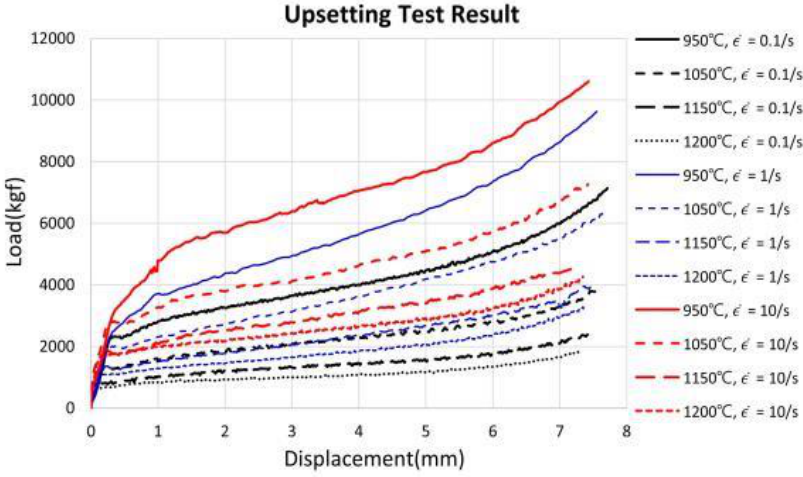
Figure 2. Load and displacement data obtained from compression tests.